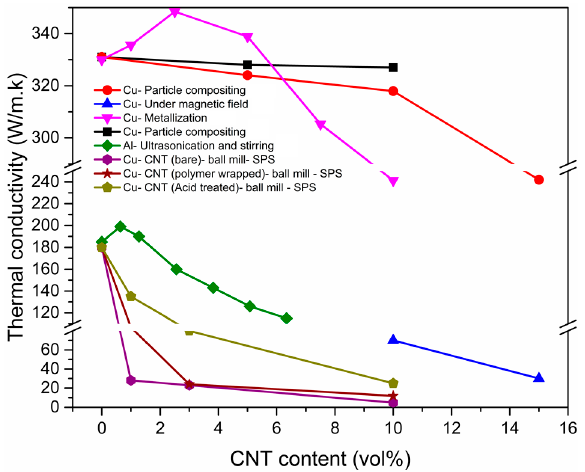
Figure 10. Thermal conductivity of some SPSed CNT-Cu and CNT-Al matrix nanocomposites fabricated by various dispersion methods [48,98–103].